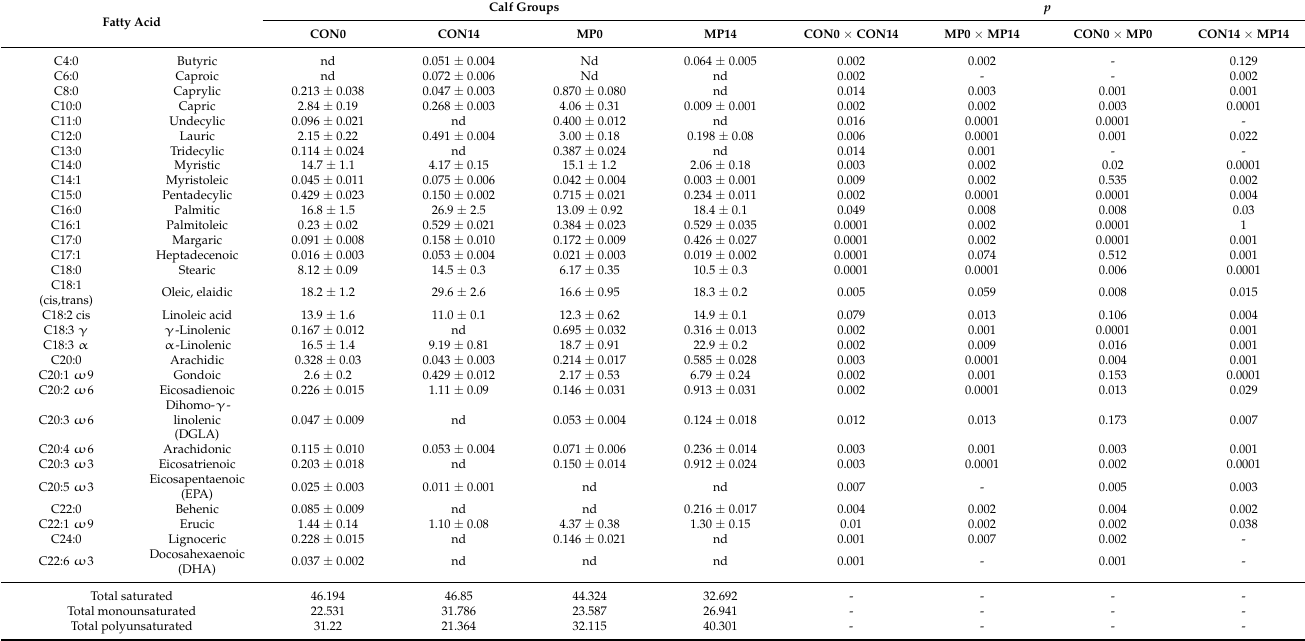
concentrations of propionic and butyric acids in the MP0 group were significantly higher (by 2-fold and 77%, respectively) than in the CON0 group. There were also significant dif- ferences between the CON14 and MP14 groups in the concentration of each SCFA ( p < 0.05), with the exception of caproic acid. After 14 days, the predominant SCFA in the faeces of both groups were acetic, propionic, and butyric acids. The concentration of each of these acids was significantly higher in the MP14 group than in the CON14 group by 34.3%, 57.3%, and 22.3%, respectively. However, after 14 days, these predominant SCFA had increased from baseline concentrations in both groups. Acetic acid increased 4.9- and 4.6-fold in the CON14 and MP14 groups, respectively, while propionic acid increased 19.6- and 32.9-fold, respectively, and butyric acid increased 6.2- and 4.3-fold, respectively (Table 6). Table 5. Fatty acid percentage profiles of faeces in the calf group fed with milk replacer only (CON0 and CON14 group) or supplemented with fermented milk permeate (MP0 and MP14 group).